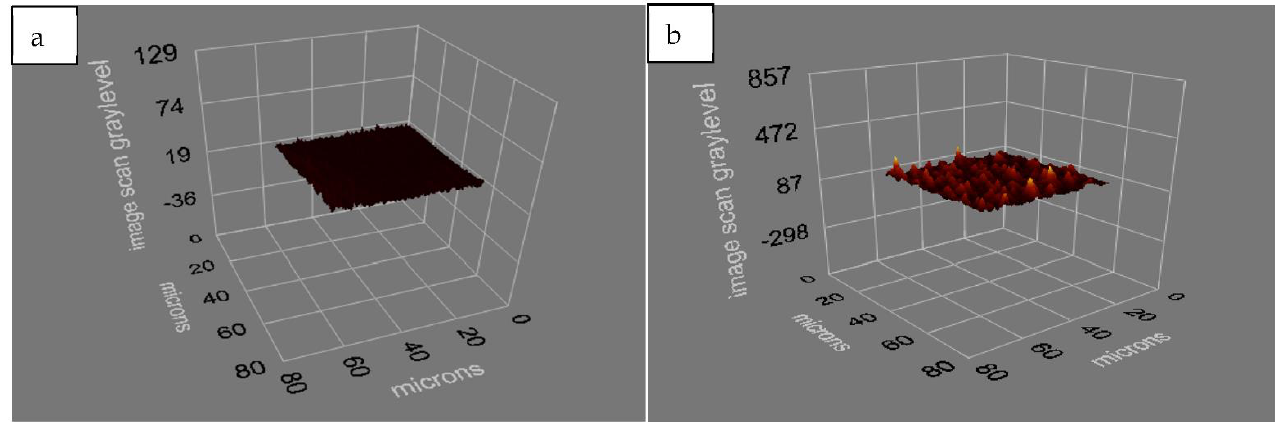
Figure 1. 3D Ellipsometric image of uncoated ( a ) and polymeric nanoparticle coated quartz crystal microbalance (QCM) chip surfaces ( b ).